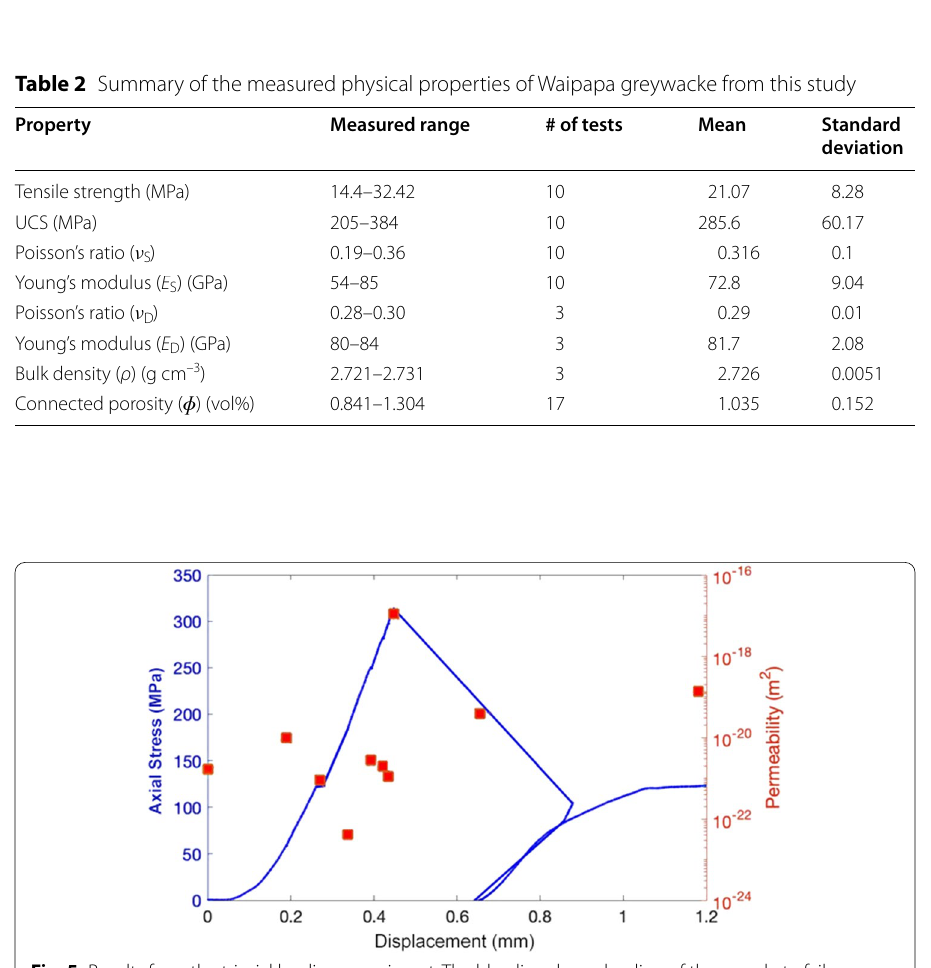
Fig. 5 Results from the triaxial loading experiment. The blue line shows loading of the sample to failure, followed by unloading and reloading the sample with the shear fracture to residual failure. The red squares show the evolution of permeability during the loading